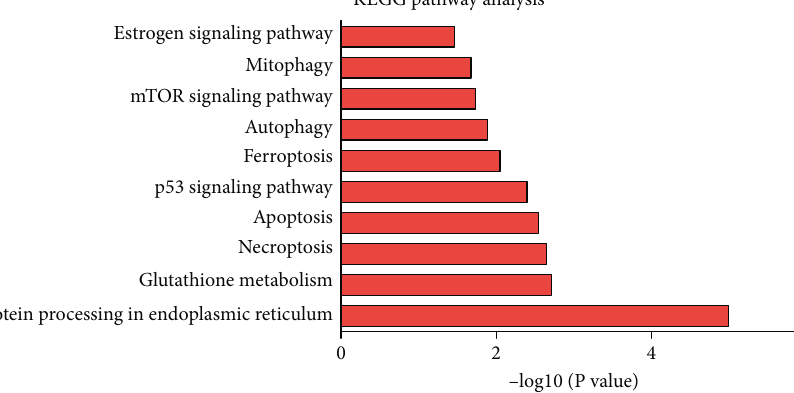
Figure 4: Kyoto Encyclopedia of Genes and Genomes (KEGG) pathway analysis discovers the biological pathway. The top ten enriched pathways were